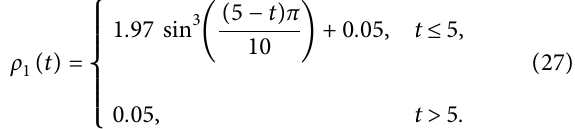
Figure 8: Time response trajectories of x and x ( t ) (14) under ρ 2